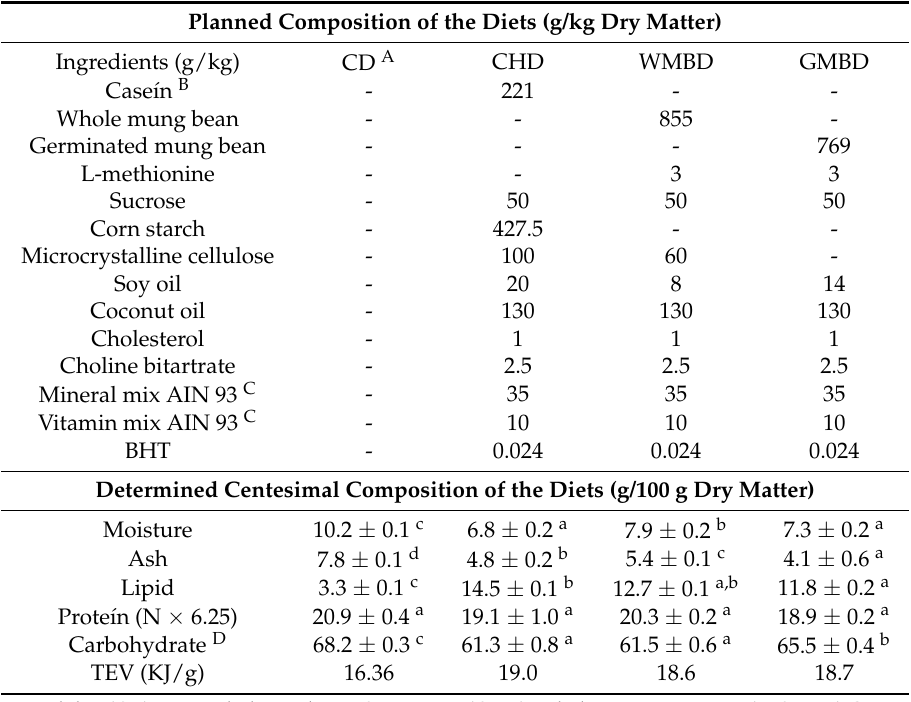
Table 2. Planned and determined centesimal composition of the control diets and experimental